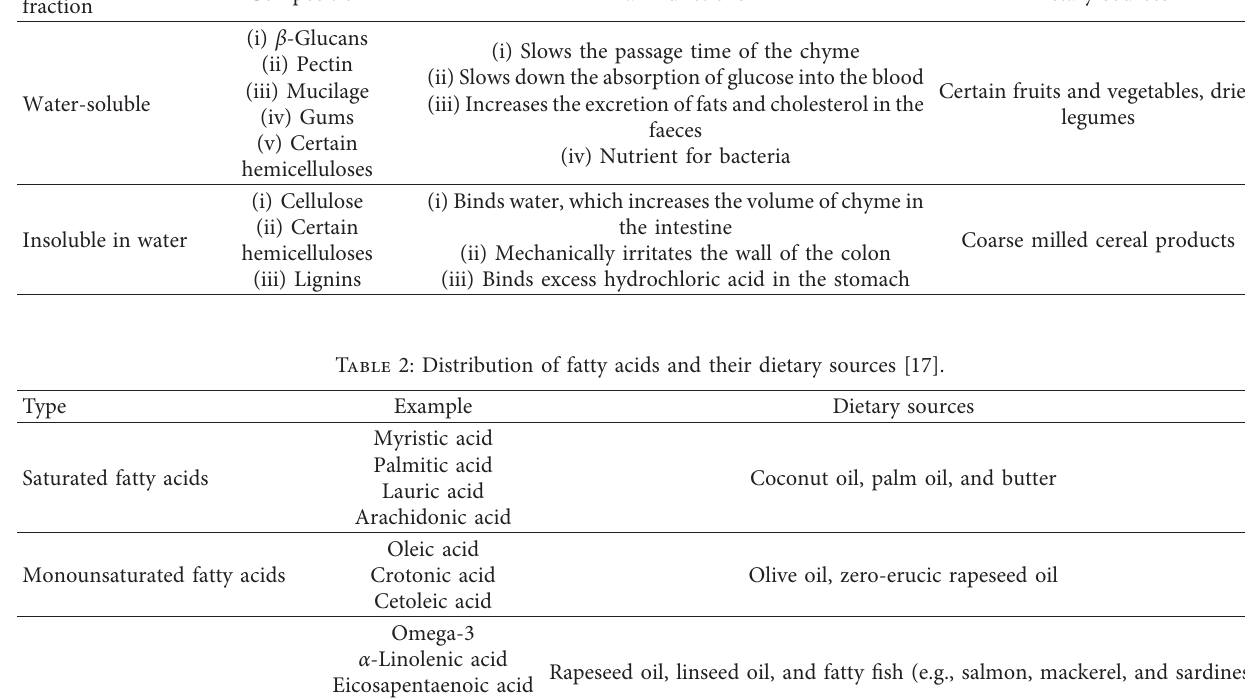
Table 1: Composition, functions, and sources of dietary fibre according to the division into fractions [9]. Dietary